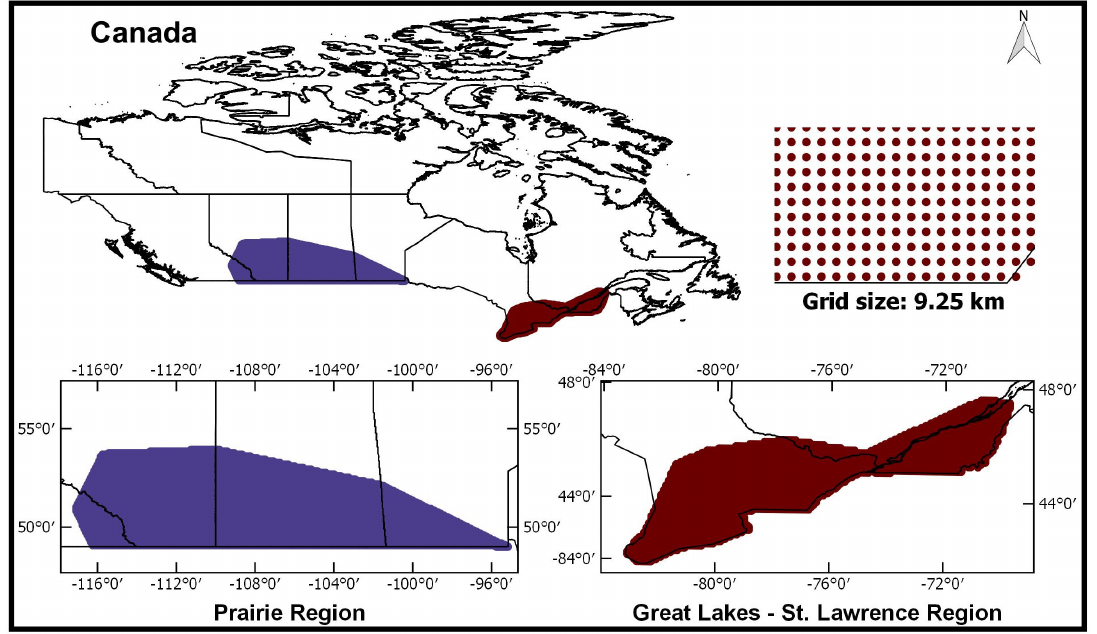
Figure 3. Location map of the climatic regions of Canada—Prairie region and Great Lakes-St Lawrence lowlands region. The grid map represents the size of the ANUSPLIN gridded